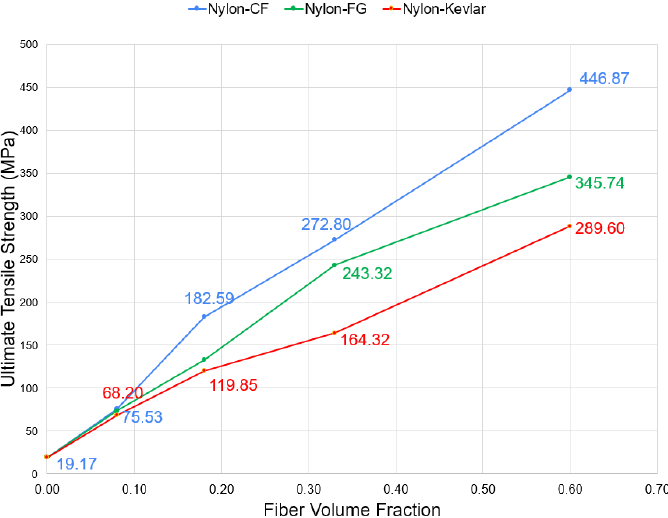
Figure 10. Effect of fiber volume fraction on ultimate tensile strength of CFRAM